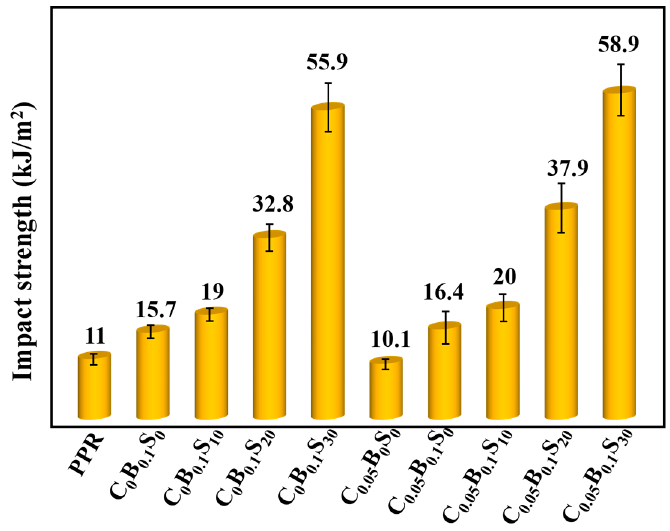
Figure1. Izod impact strength of various polypropylene random co-polymer (PPR) blends (20